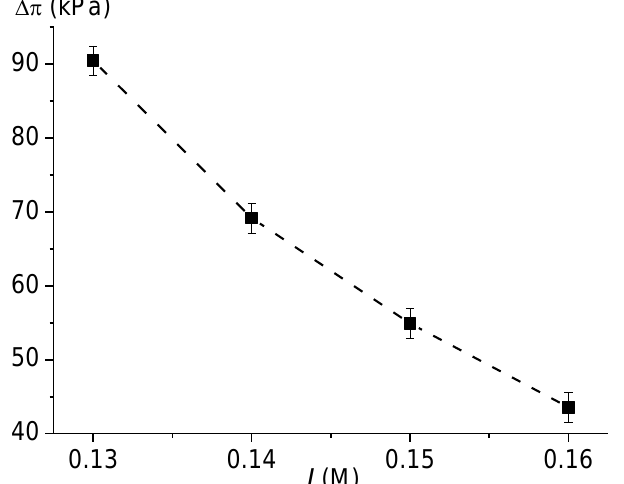
Figure 5. Gel swelling pressure ∆π measured by means of the sensor with PNIPAAm-DMAAm-DMIAAm hydrogel at 36.5 °C in dependence on ionic strength I of PBS solution.  0.16405060708090 0.13 0.14 0.15 I (M)